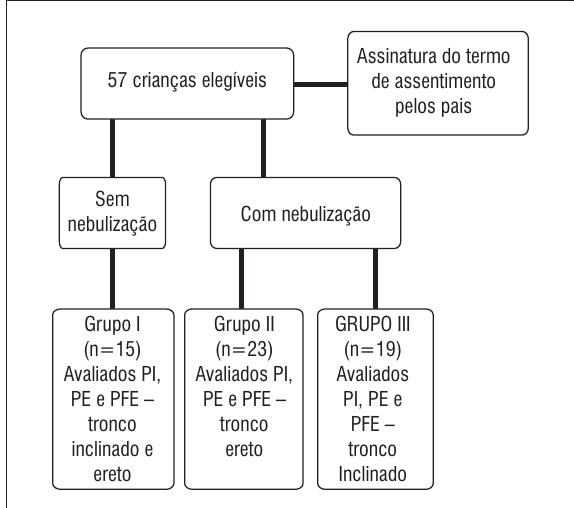
Figura 1 - Fluxograma da aleatorização Fonte: Dados da